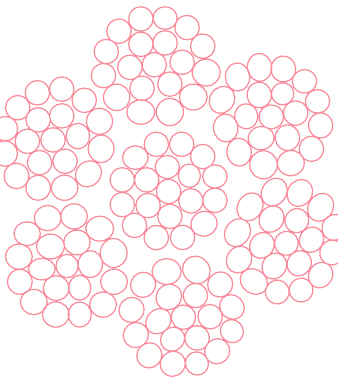
Figure 2: The cross section of the wire